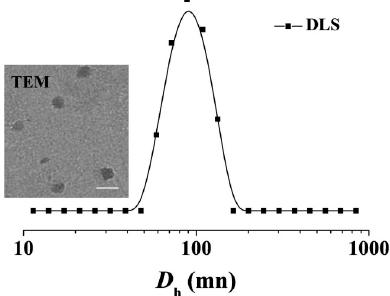
Figure 2. Typical TEM micrograph (inset) and D h of mPEG- b -PGA/EPI in PBS. Scale bar: 200.0